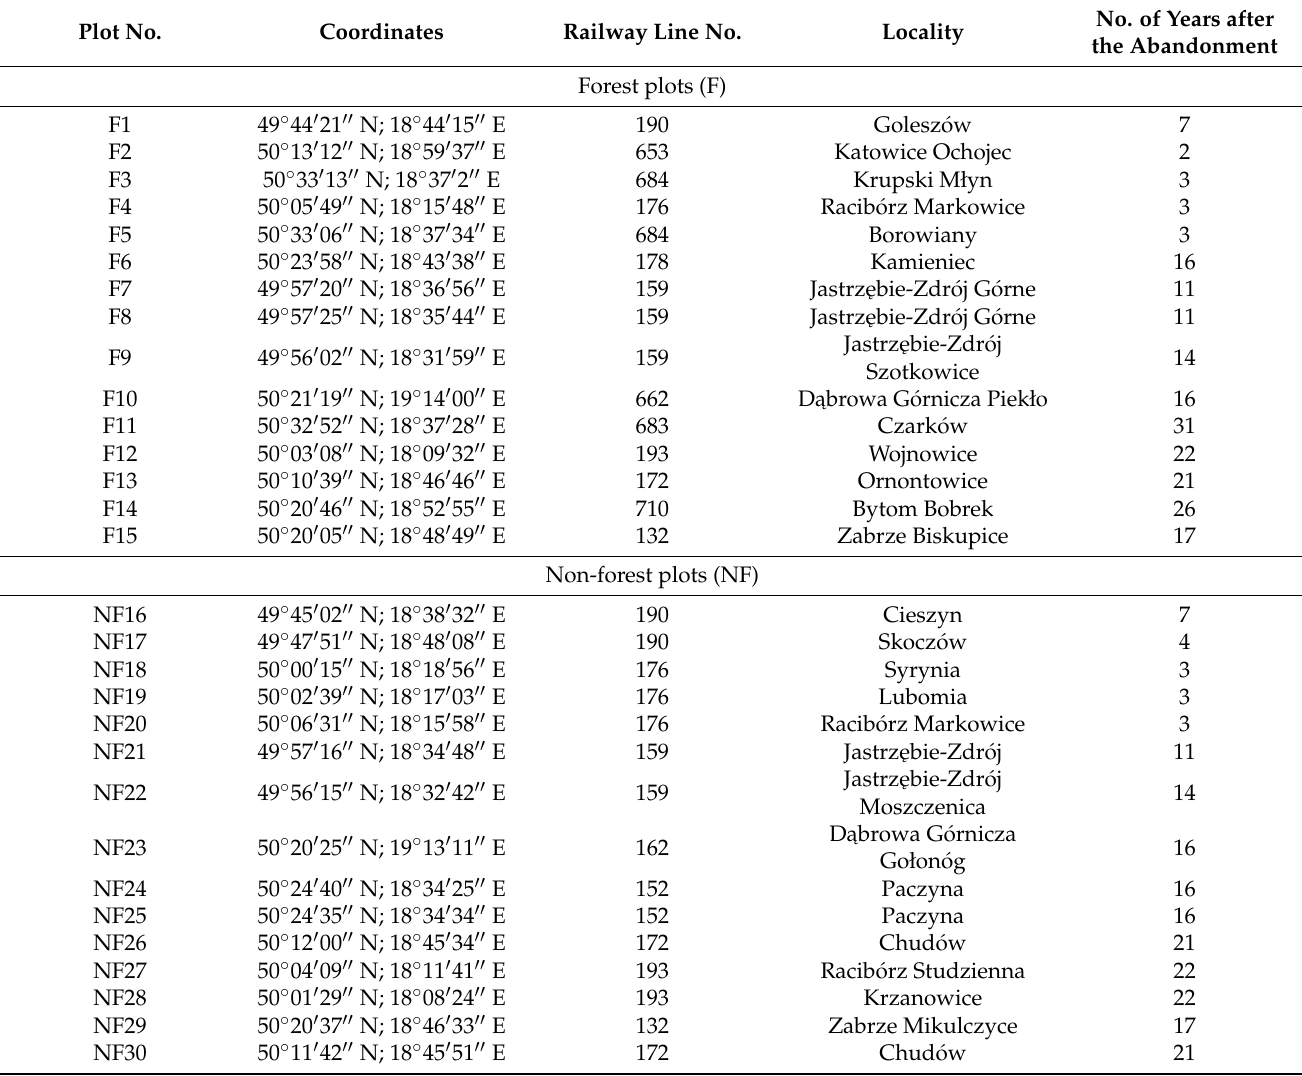
Table 1. Characteristics of the investigated